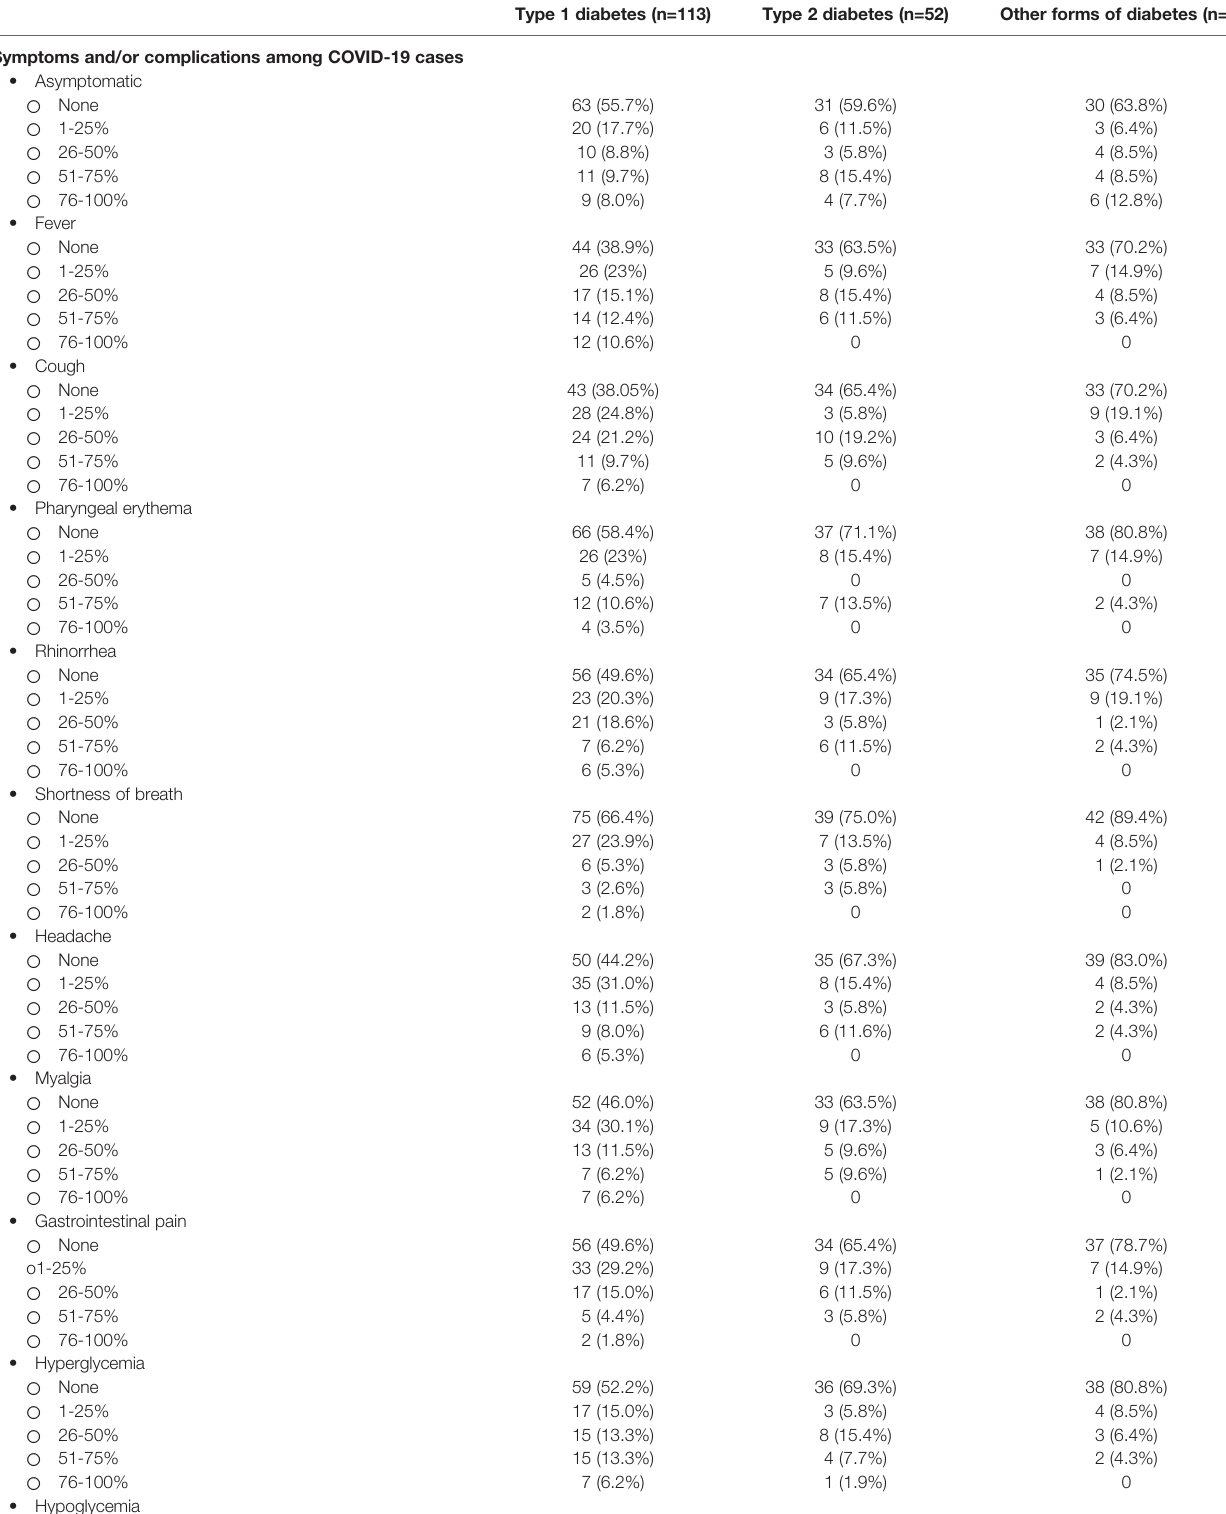
TABLE 4 | Symptoms, complications, and outcomes of pediatric diabetes cases during the COVID-19 pandemic by clinical